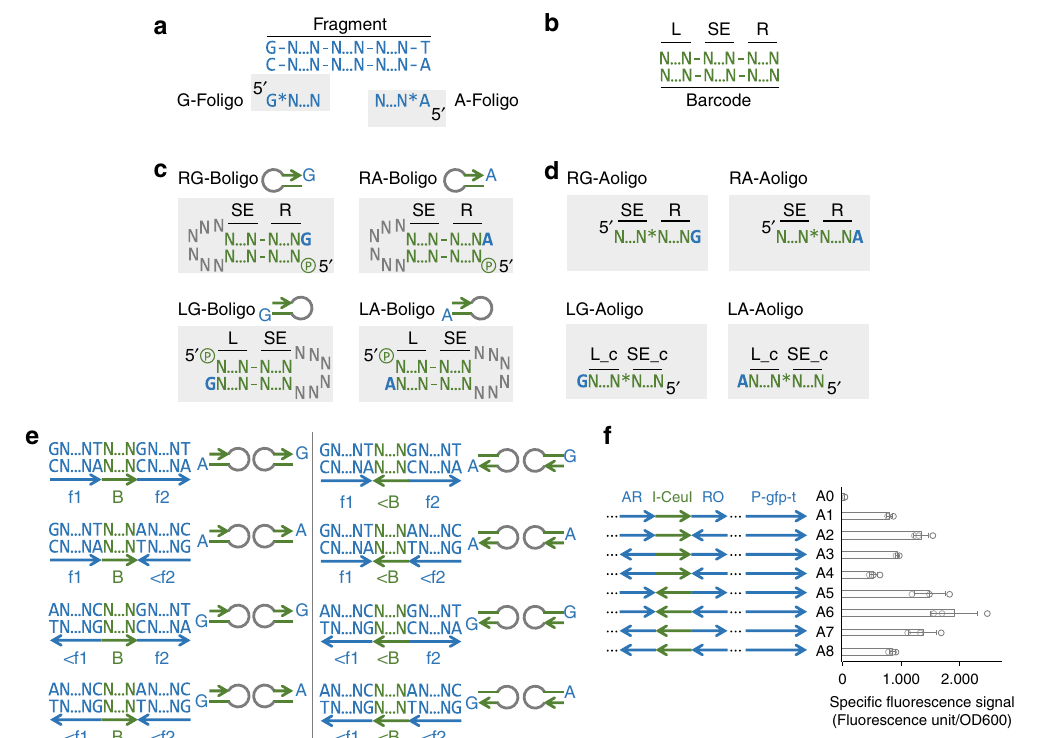
Fig. 5 Principles of designing and using the oligos under GTS. a PS-modi fi ed Foligos are used to amplify fragment by using PCR. Position of each PS bond is shown. b Structure of barcodes. Any barcode is composed of L, SE, and R. L and R can be empty. SE should be 15 – 20 nt depending on its melting temperature and should not contain any sequence that may result in self-ligation. c There are four Boligos to encode all the variants of a barcode. The six nucleotides (NNNNNN in gray) can be any sequence as long as the illustrated stem-loop structure can be formed. The arrow in Boligo indicates the strand on which the barcode half is encoded. The length of Boligo is no longer than 90 nt. Each Boligo has a corresponding Aoligo. * Indicates a PS bond; − indicates a phosphodiester bond. There is one more PS bond at the center of each SE (not shown for simplicity), which is used to improve DNA assembly ef fi ciency. d Instructions for connecting two fragments (f1 and f2) through one barcode (B) in eight ways. Pre fi x “ < ” indicates that a part is fl ipped; The blue arrows below sequences indicate fragment ’ s orientation, while green arrows indicate barcode ’ s orientation. The pair of Boligos used in each way is shown at the right side of each sequence. The nucleotides (G and A) used in fragment-barcode ligation are shown in bold font. e Demonstration of the eight connection options in a simple example. AR: antibiotic resistance marker (Spec R ); I-CeuI: a barcode containing a 19 bp RE recognition site; RO: replication origin (pMB1); P: promoter; gfp : a gene encoding green fl uorescence protein; t: terminator. f Each row indicates a plasmid (A1 – A8). Arrow indicates the orientation of fragment/barcode. Only relevant parts of each plasmid are illustrated. Each plasmid ’ s performance (i.e., speci fi c fl uorescence signal) is shown in the chart. Empty circles indicate values of replicates. Each bar indicates the mean of triplicates at each condition. Empty plasmid (A0) without gfp was used as a negative control. Error bars indicate standard error ( n =